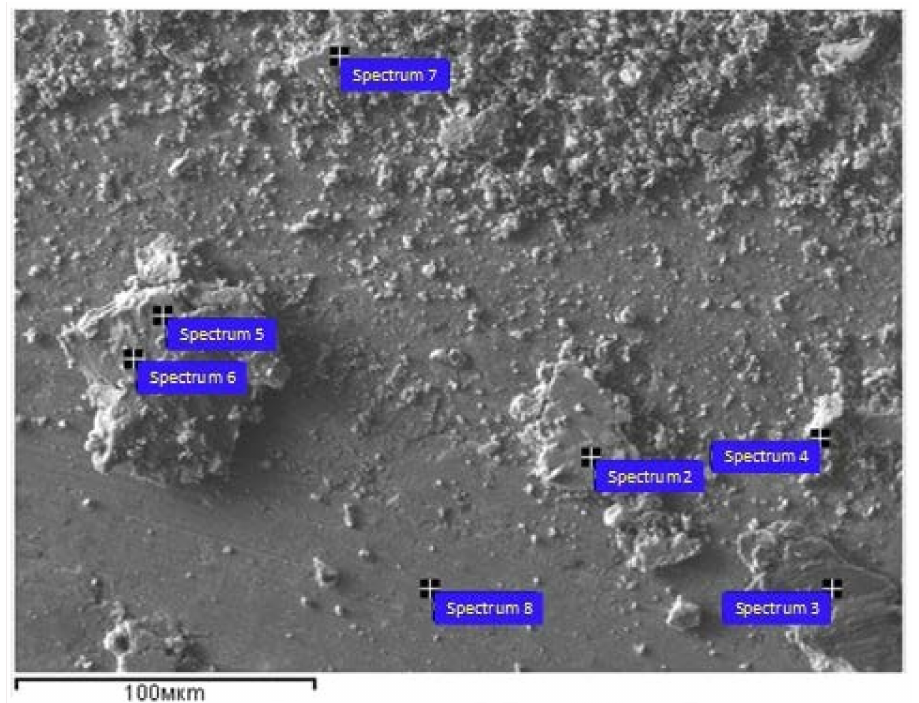
Figure 16. SEM image of worn surface obtained on the 15% Ud sample at 9 N normal load. 2–8 are the points where EDS spectra have been obtained (Table